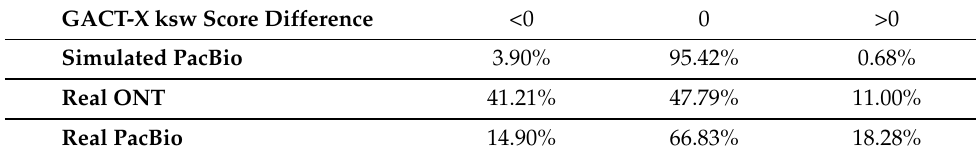
Table 4. Minimap2’s ksw and GACT-X’s alignment score differences for three